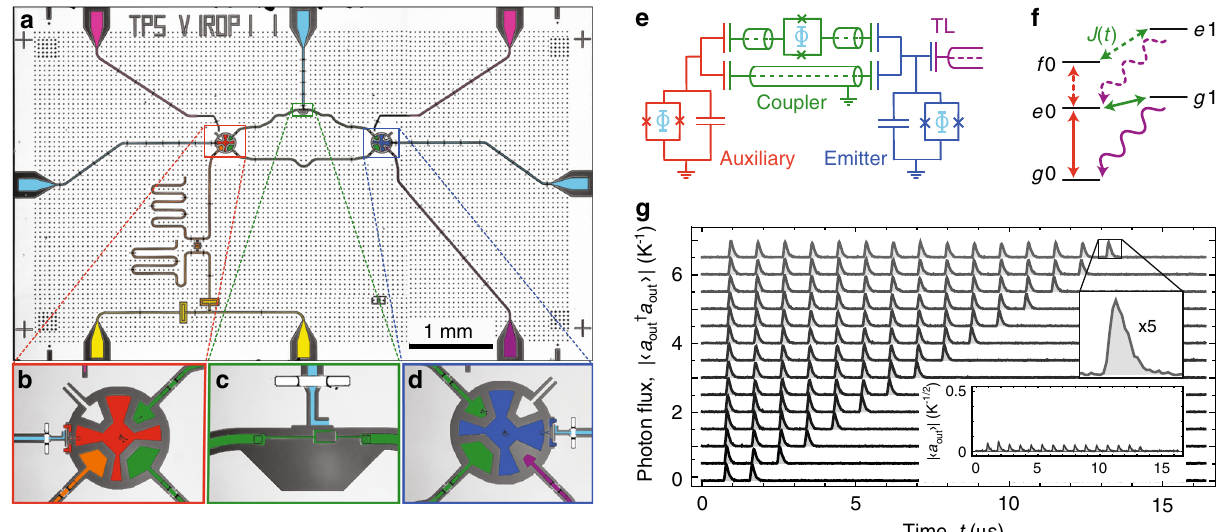
Fig. 2 Experimental implementation with a superconducting circuit. a False color optical micrograph of the chip used in the experiment, comprising an auxiliary qutrit (red, b ), a tunable coupler (green, c ), an emitter qubit (blue, d ), an output transmission line (purple) connecting to the measurement chain, a feedline (yellow), a readout circuit with Purcell fi lter (orange), three fl ux lines (cyan), and two charge lines (pink). e Equivalent electrical circuit diagram. The auxiliary and the emitter qubits are transmons, with a fl ux tunable superconducting quantum interference device (SQUID) loop capacitively shunted to ground. The coupler consists of two paths, one mainly inductive (top), the other capacitive (bottom). Photons are emitted into the semi-in fi nite transmission line (TL). f Energy level diagram, indicating the possible transitions induced by single-qubit gates (red), parametric modulation of the coupler (green), and photon emission via spontaneous decay into the TL (purple). g Measured outgoing photon fl ux h a y units of inverse emitter linewidth κ , for cluster states of N = 2, . . . , 15 modes. Traces are offset by 0.5 for clarity. Insets: zoom-in by a factor 5 of the last (cid:4) time bin for clarity, and amplitude h a out i